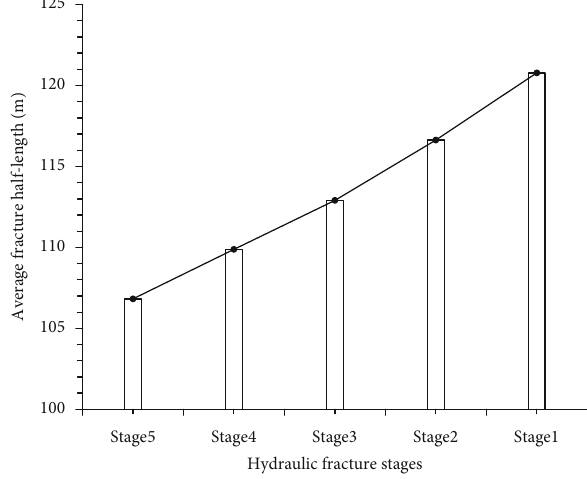
Figure 8: Multistage hydraulic fracturing with respect to transient temperature